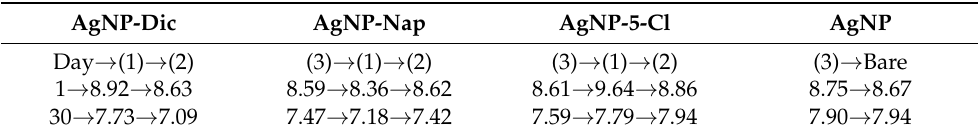
Table 1. pH of NP suspensions: day 1 and day 30.